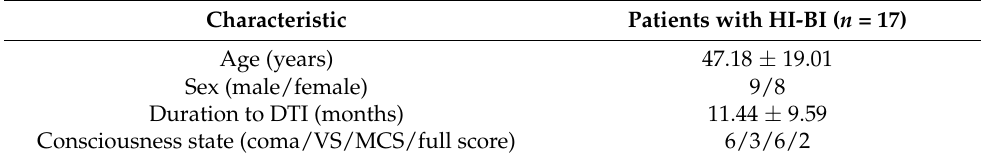
Table 1. Demographic and clinical data of the patients with hypoxic–ischemic brain